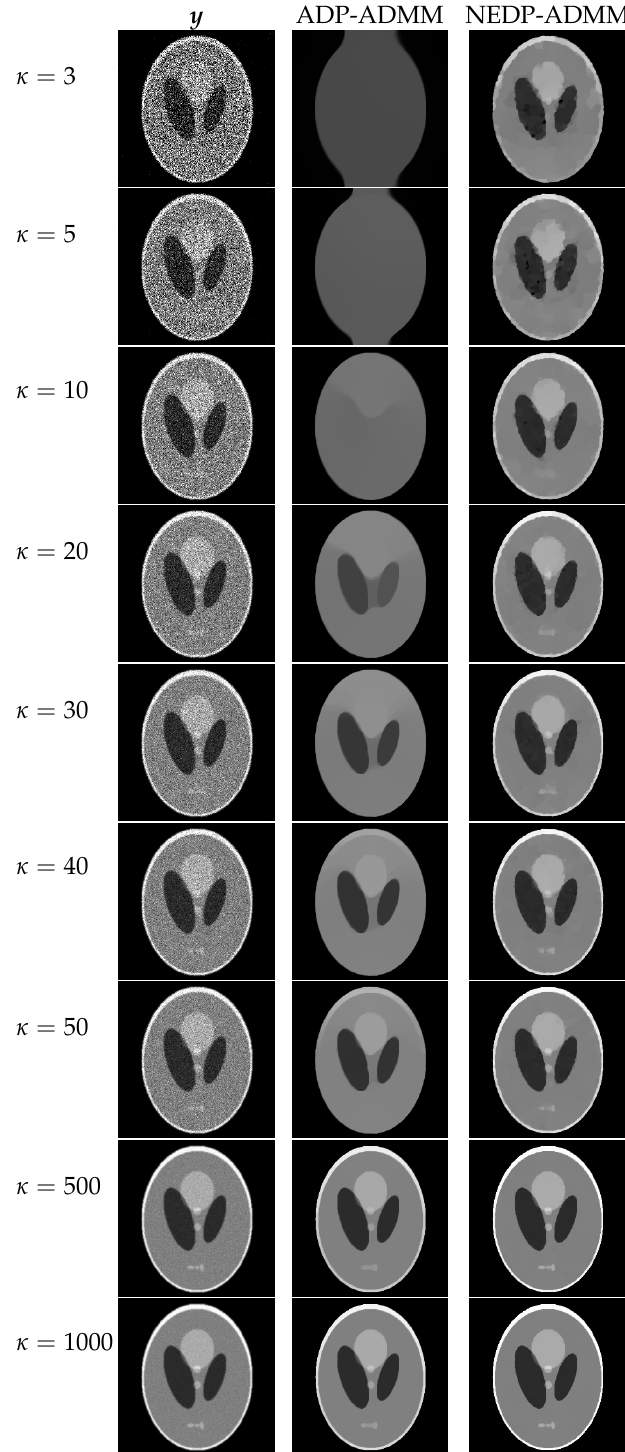
Figure 13. Test image phantom . Left column: observed data y corrupted by Gaussian blur with parameters band = 5, sigma = 1 and Poisson noise with different κ -values ranging from 3 to 1000. Middle column: restorations by ADP-ADMM. Right column: restorations by